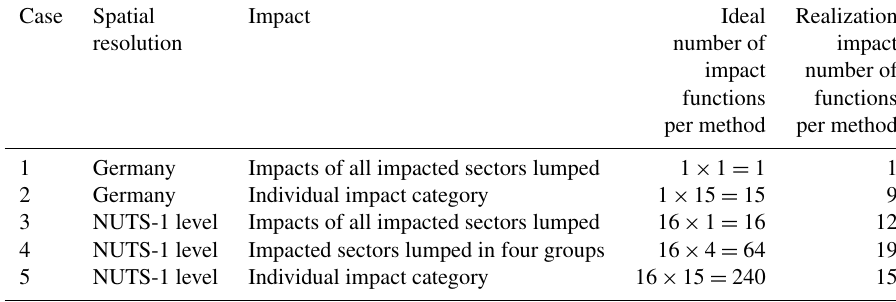
impact number of functions functions per method per method